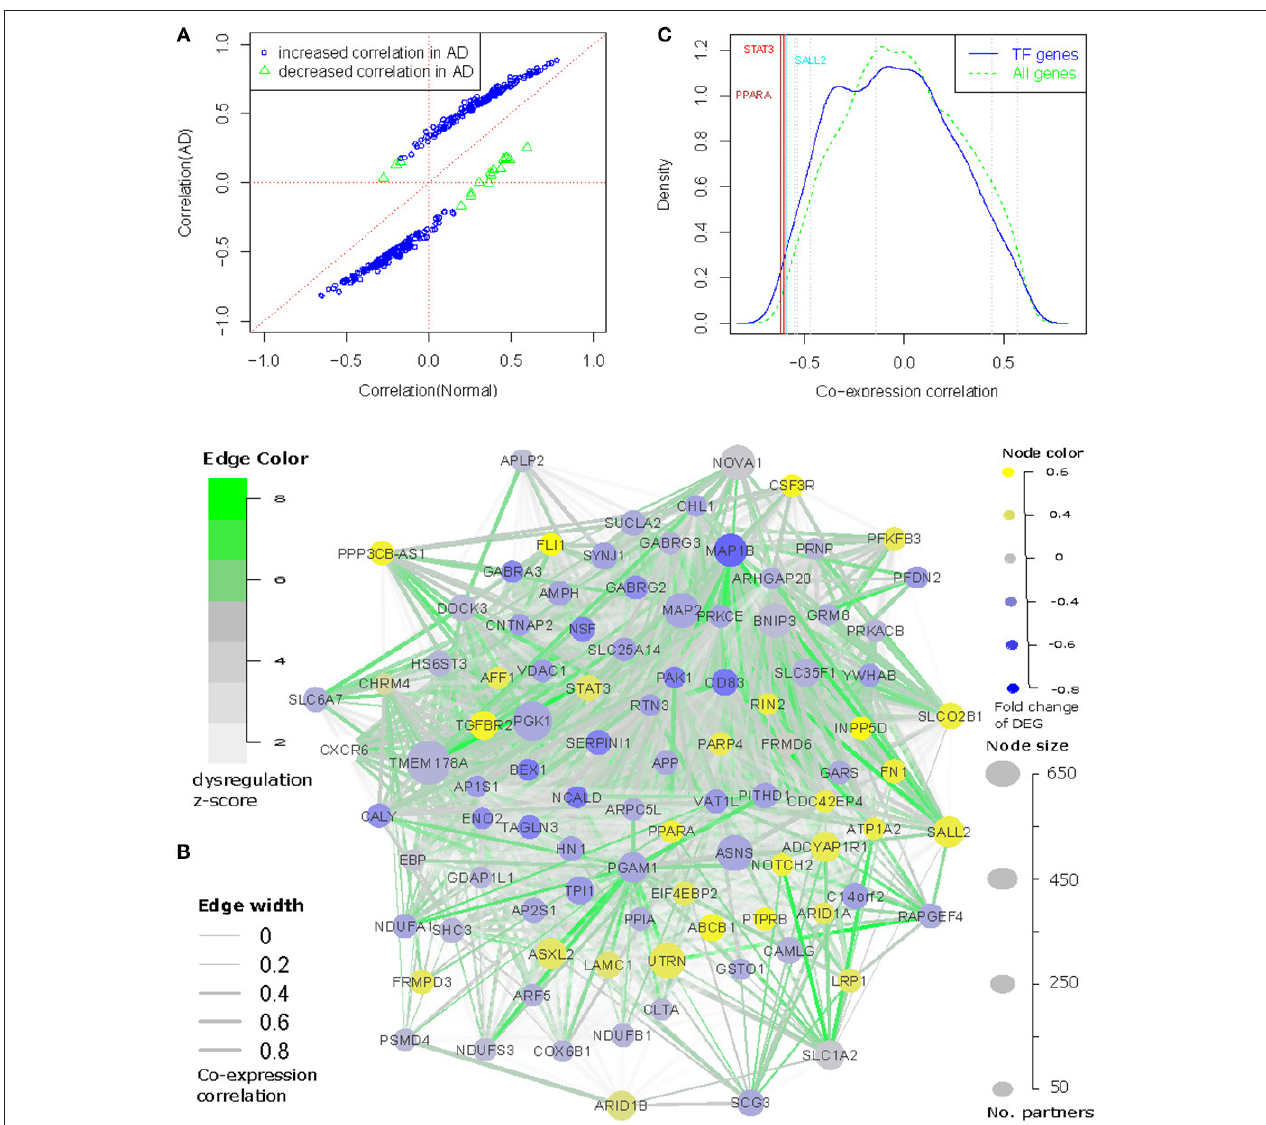
FIGURE 3 | The core network involving the dysregulation of AD. We connected the dysregulated genes as a network and found that (A) Majority of the dysregulated genes have increased correlations (both direction) in the transmit from normal to AD; (B) 96 (out of 97) dysregulated genes can be interconnected as a regulatory network based on co-expression and differential co-expression information. (C) TMEM178A expression is negatively correlated with dysregulated transcription factors, among which PPARA is ranked as the most negatively correlated transcription factors. we found 165 out of 669 genes to be aging related genes ( p = 3.2 e − 20 by Fisher’s exact test). Out of 2,862 aging genes,